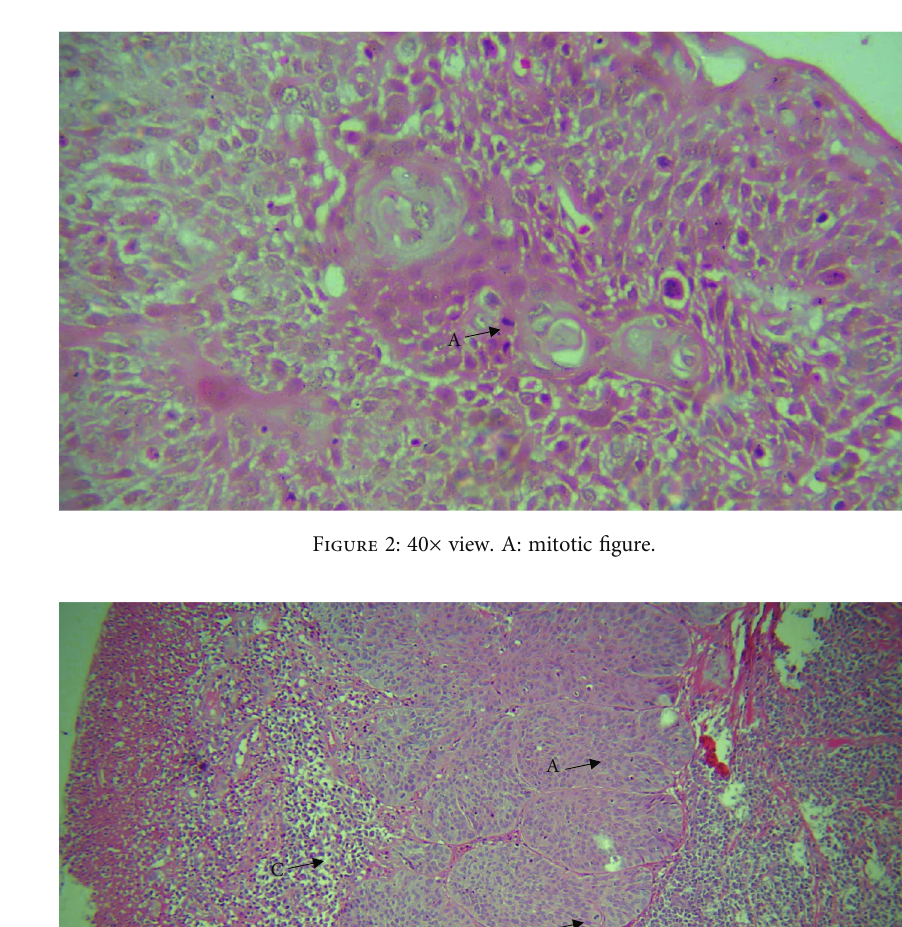
Figure 1: 10 × view. A: squamous cells; B: basaloid cells; C: keratin pearl; and D: area of comedo necrosis.